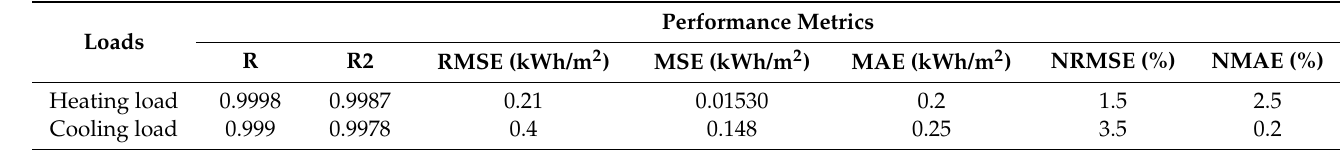
Figure 8. ( a , b ) Developed model performance using varying sample sizes in the training and testing sets. Table 2. The suggested approach results in terms of predicting heating and cooling